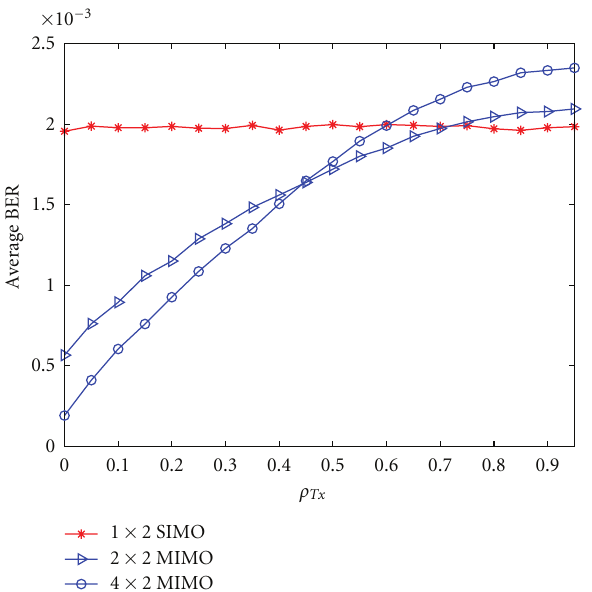
Figure 5: BER performance versus transmit correlation coe ffi cient, for CM1 channels.